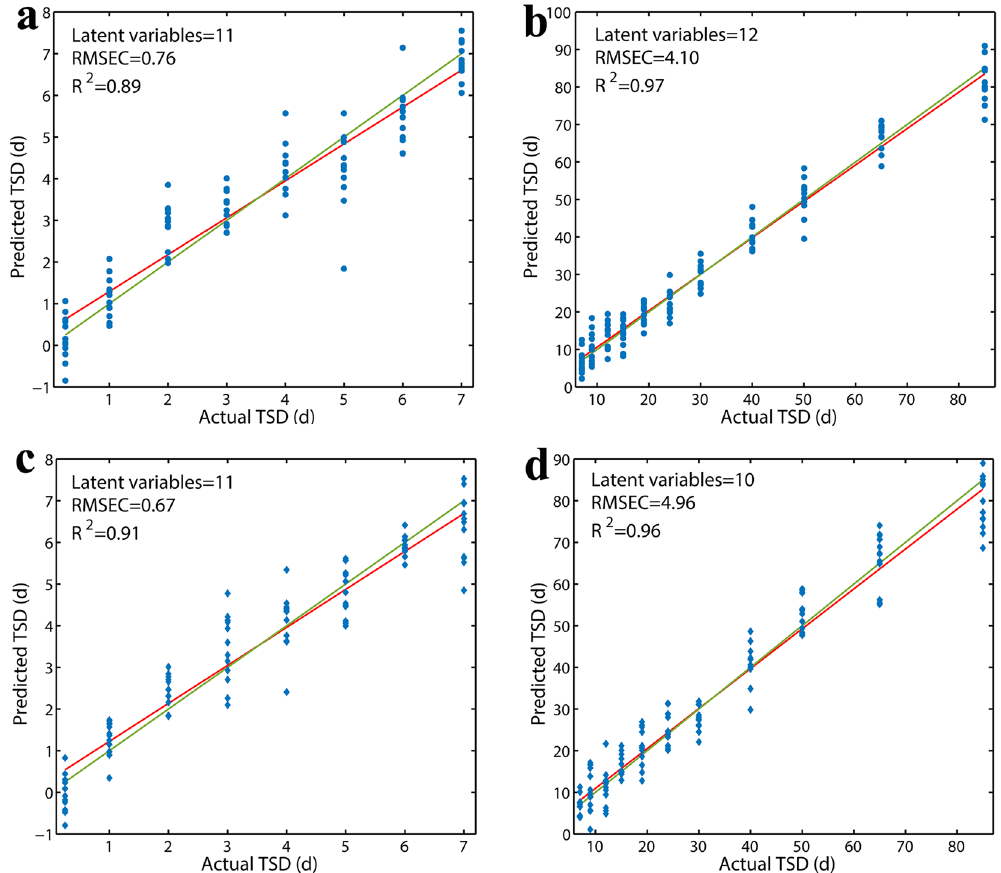
Figure 3. PLSR plots for indoor bloodstain samples in the ( a ) 0.25- to 7-d and ( b ) 7- to 85-d periods and outdoor bloodstain samples in the ( c ) 0.25- to 7-d and ( d ) 7- to 85-d periods showing the calibrated age predictions versus the actual